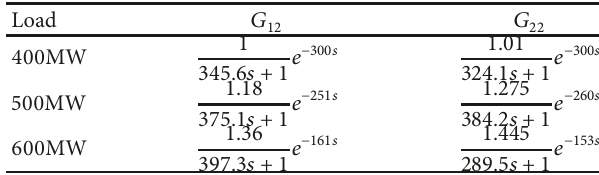
Table2:Themodelofburnerswingangle-reheatsteamtemperature under 400 MW, 500 MW, and 600